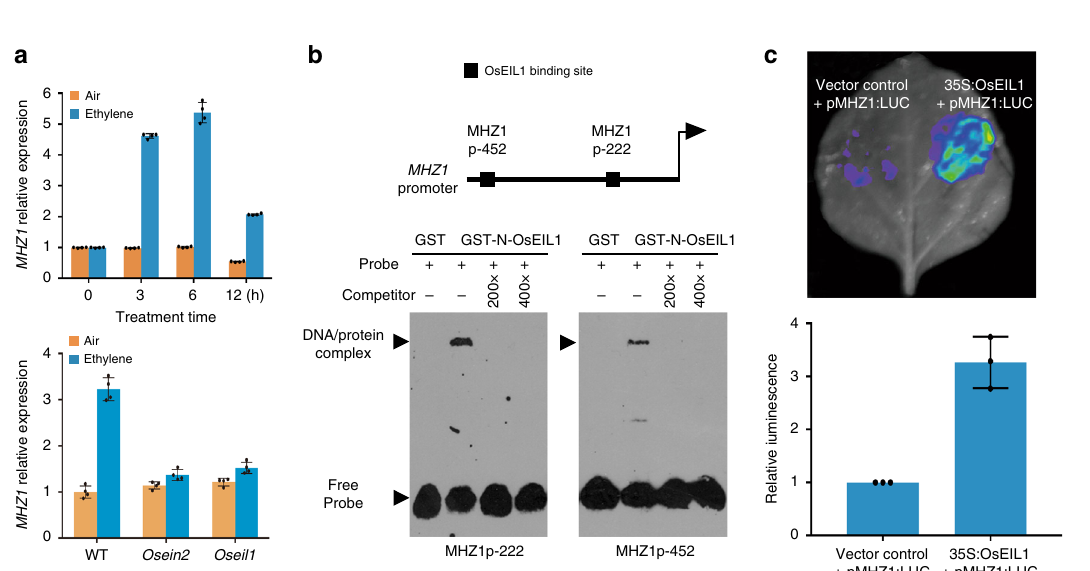
Fig. 1 MHZ1 positively regulates the ethylene response in rice roots. a Ethylene response phenotype of mhz1 alleles. Etiolated seedlings were treated with various concentrations of ethylene in darkness. Representative seedlings grown in the air and in 10 ppm ethylene are shown (Left). Coleoptile (Center) and root lengths (Right) are means ± SD, n > 30. Bars indicate 10 mm. b MHZ1 genomic structure and mutation sites of different mhz1 alleles. Colored boxes indicate exons and horizontal lines indicate introns. c Schematic structure of MHZ1 and mutation sites of different mhz1 alleles. d MHZ1 gene expression in WT and mhz1-1 . Actin1 was ampli fi ed as internal control. e MHZ1 overexpression lines ( MHZ1-OE ) have constitutive ethylene response. MHZ1 native promoter was used to drive the MHZ1 cDNA for overexpression. Etiolated seedlings were treated with various concentrations of ethylene and 10 ppm 1- MCP under darkness. Bars indicate 10 mm. Root lengths (Right) are means ± SD, n > 30. f Expression of ethylene-inducible genes OsRRA5 , OsERF002 OsRAP2.8 , OsERF063 and OsERF073 in mhz1-1 and MHZ1-OE lines compared with WT as revealed by qPCR. Data are means ± SD, n = 4. Source data are provided as a Source Data fi le.